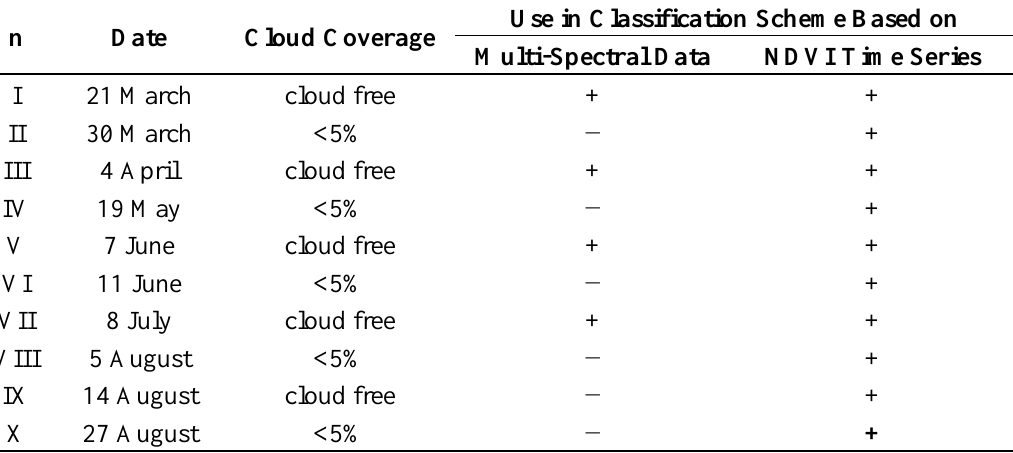
Table 3. PROBA-V 100 m and 300 m image acquisitions used in the